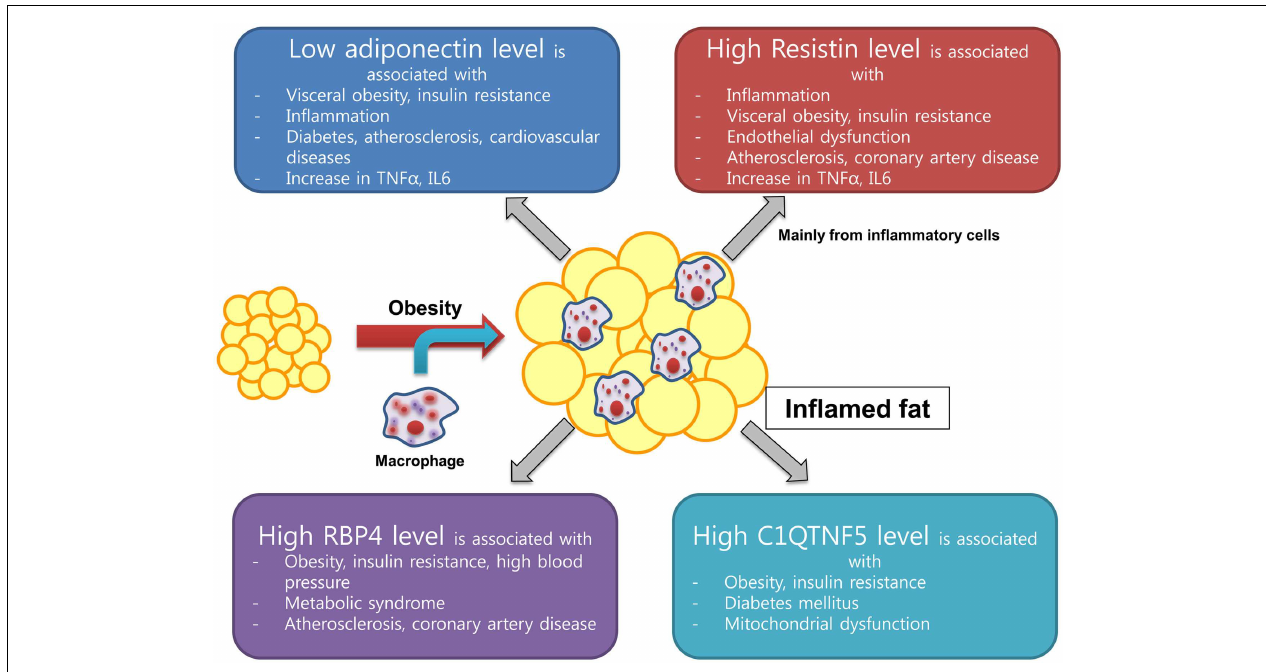
FIGURE 1 | New emerging adipokine from inflamed fat and its association with insulin resistance and cardiovascular health .